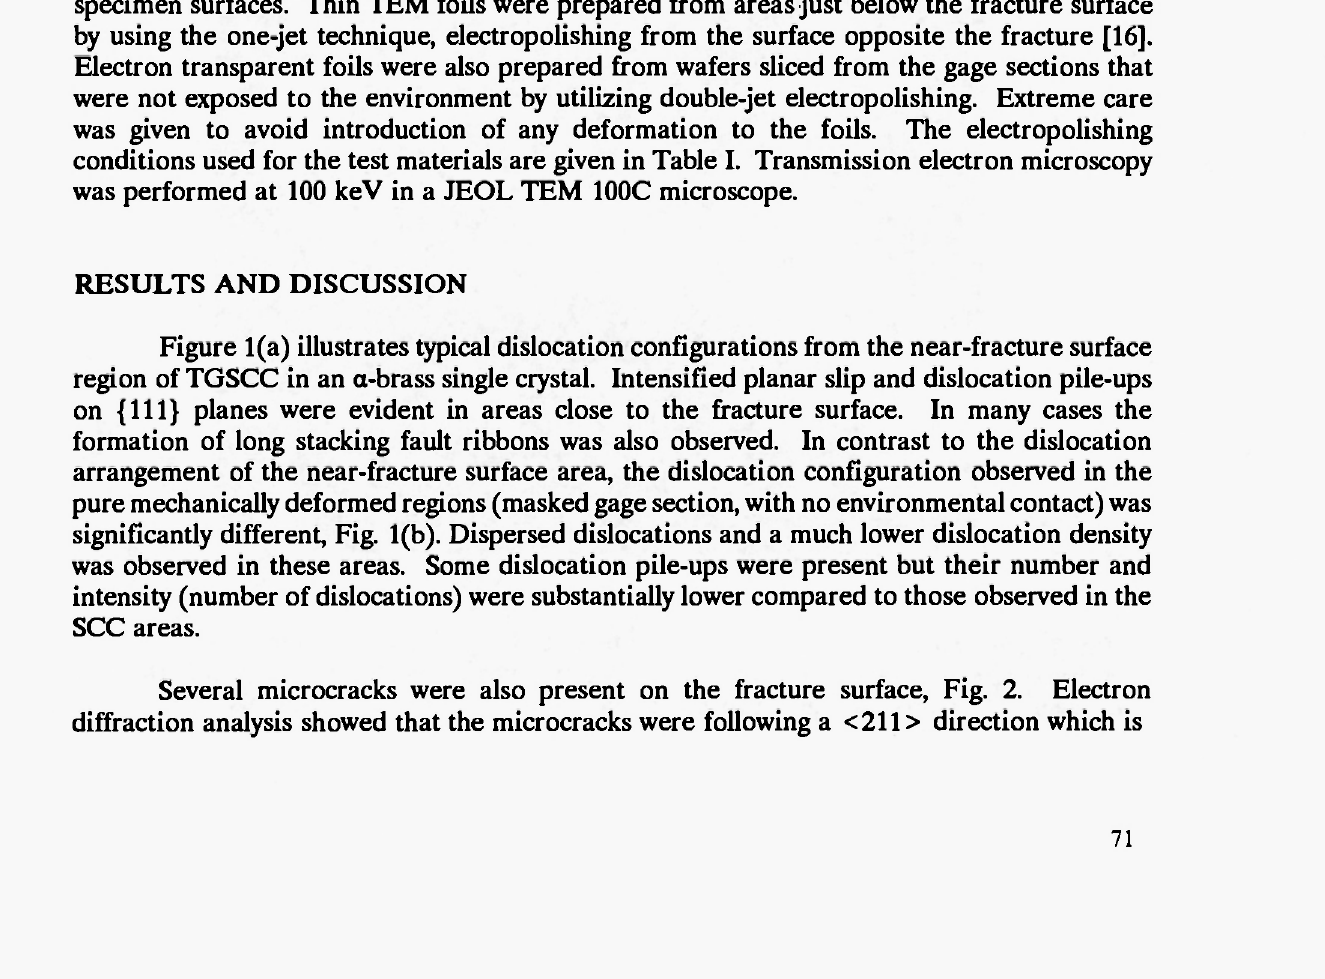
Table I. Electropolishing Conditions for the Test